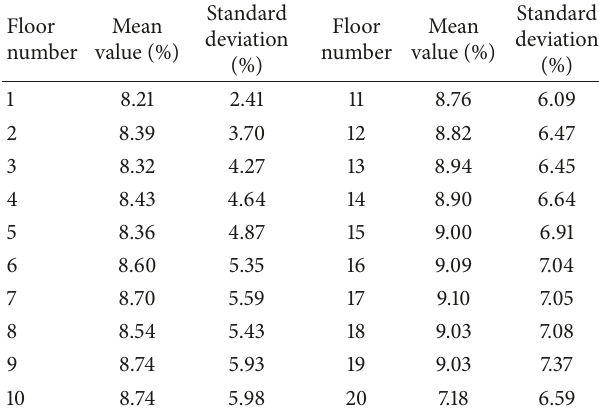
Table 2: Number of sensors and corresponding locations. Number of sensors